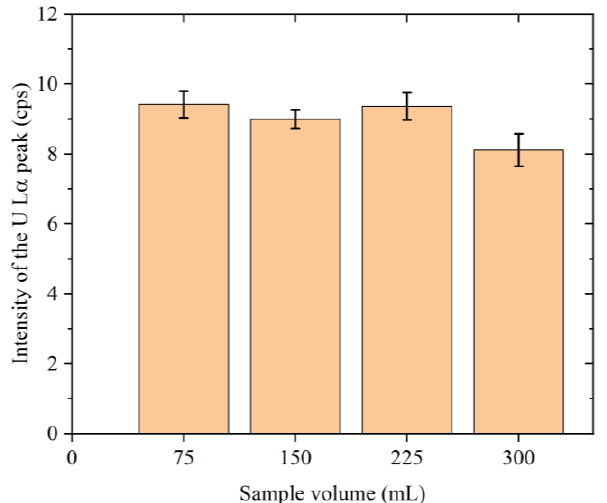
Figure 4. Relationship between the sample volume and the intensity of the U L α peak for the standard sample. The error bars represent the standard deviations of the results obtained from six